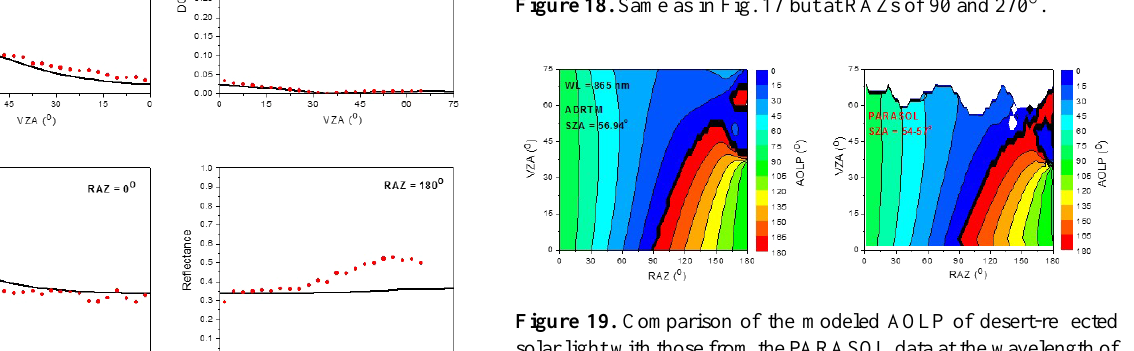
Figure 18. Same as in Fig. 17 but at RAZs of 90 and 270 ◦ .